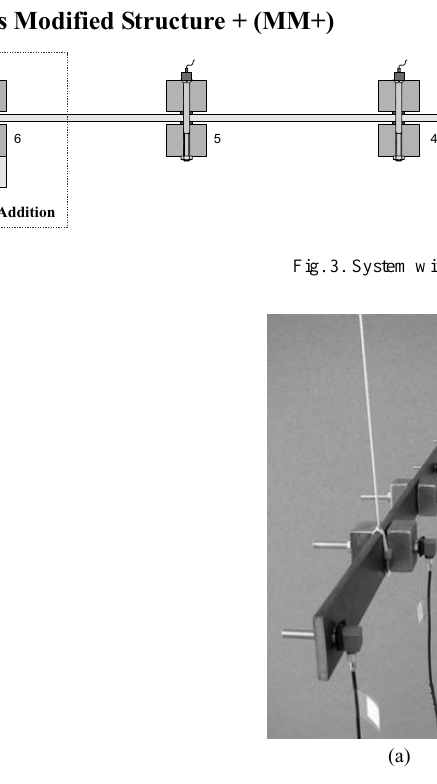
Fig. 4. (a) Suspension and measurement set-up; (b) Excitation